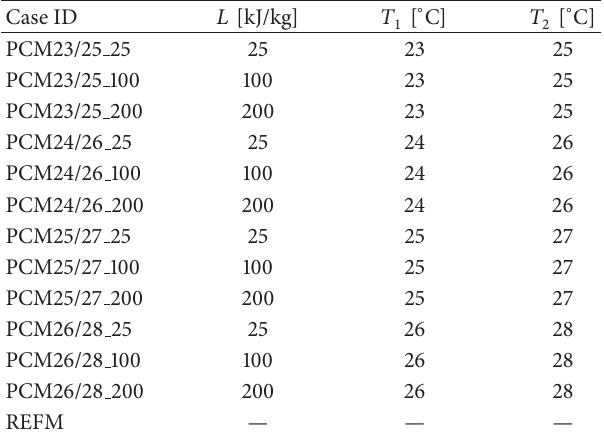
Table 5: “Free-floating”